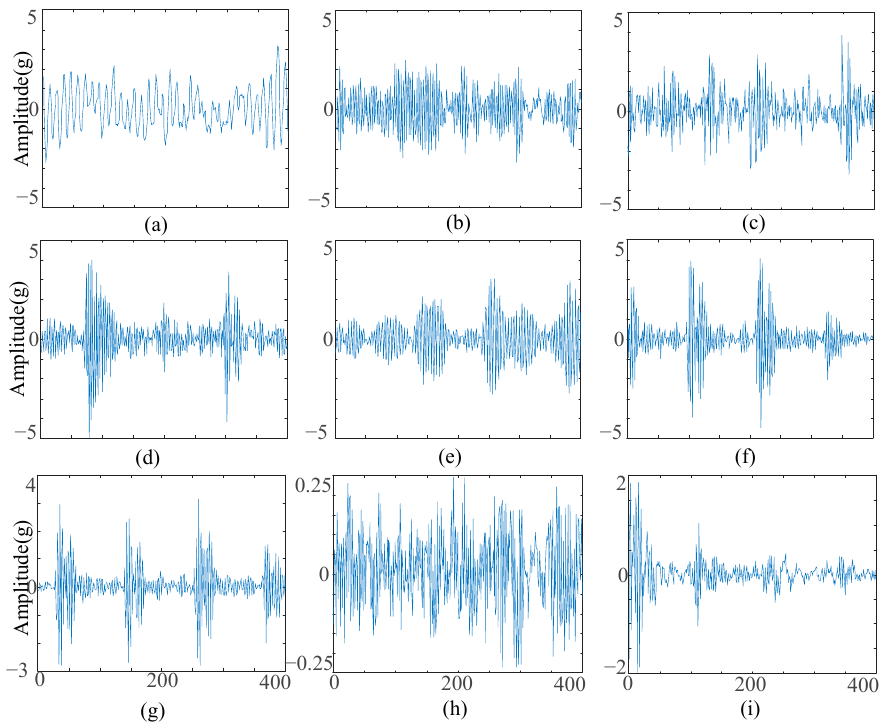
Figure 8. The waveforms of nine types of fault samples. ( a – i ) correspond to the waveforms of Label 1–Label 9 of Table 1, respectively. Table 2. Features used in the